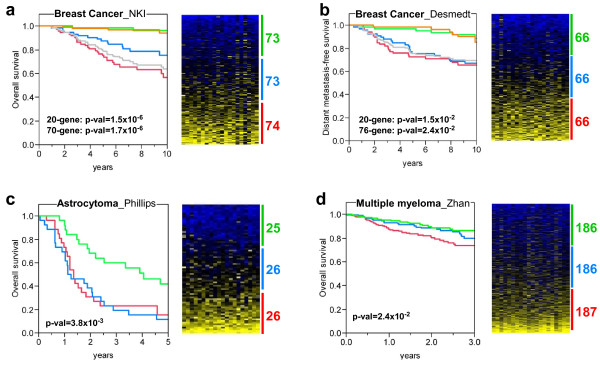
20-gene signature can identify patient tumor samples with poor outcome from different human cancer types. Three human cancer types were analyzed: breast cancer [31,32] (a and b), astrocytoma [51] (c) and multiple myeloma [50] (d). The probeset with maximal values was selected for those genes with multiple probesets. Expression values for each gene were mean centered (mean = 0, stdv = 1), and the sum of the expresion values of the 20 genes for each patient sample was computed (20-gene score, see Materials and Methods). Each dataset was divided in three groups of patients depending on the 20-gene score, and the survival of each group was represented in Kaplan-Meier curves. Note that the patients with lower scores (green color) display better survival than those with intermediate or higher scores (blue and red colors, respectively). Survival curves for good prognosis (orange line) and poor prognosis (grey line) breast cancer patients according to 70-gene and 76-gene prognosis profiles are showed (a and b, respectively). Significance of the survival differences is shown (p-val, Wilcoxon signed-rank test). On the right of each survival plot, there are heat maps of the corresponding datasets, and the numbers represent the number of patients in each 20-gene score group. From top to botton, the samples are ranked from lowest to highest 20-gene scores. From left to right, expression values of AURKA, BIRC5, BUB1, CCNA2, CDC2, CDC20, CDKN3, CENPA, CHEK1, CKS2, HMMR, KIF2C, KPNA2, MAD2L1, MCM4, NCAPH, PLK1, TOP2A, TPX2, and UBE2C.